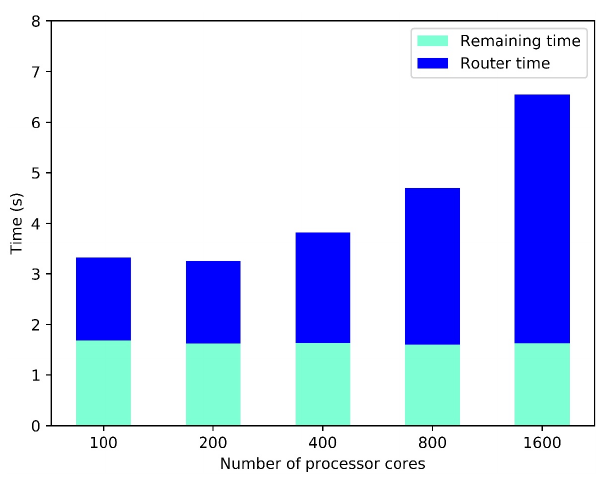
Figure 2. The total time of routing network generation (router time) and the remaining time for initializing a two-way MCT coupling be- tween two toy component models. One toy component model uses a longitude–latitude grid with 4 million points and a regular 2-D par- allel decomposition, while the other uses a cubed-sphere grid with a resolution of 0.3 ◦ and a round-robin parallel decomposition. The time for reading an offline remapping weight file has been taken into account in the remaining time. The supercomputer, as well as the corresponding software stacks described in Sect. 4, is used for this